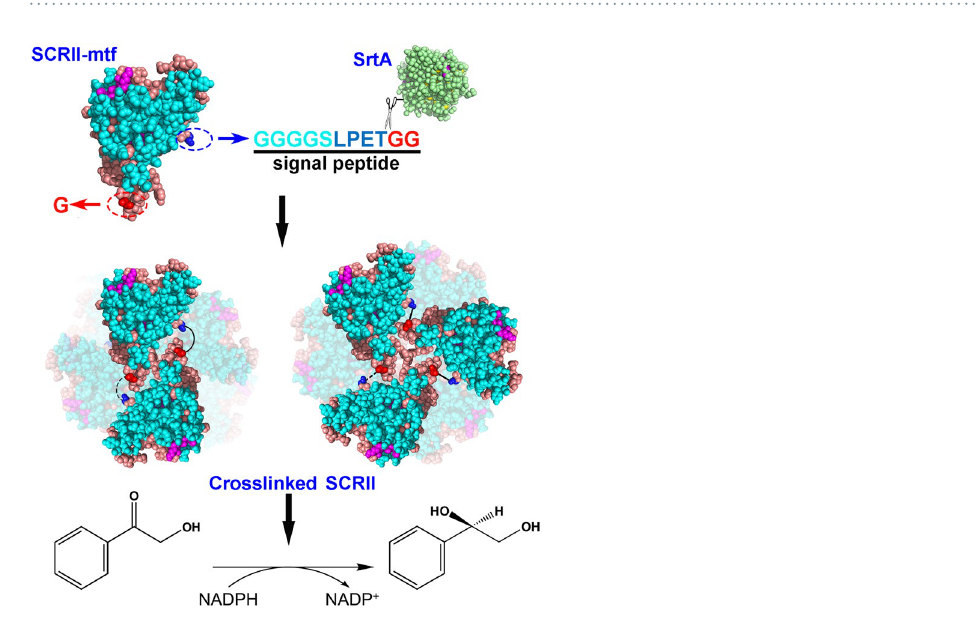
Figure 1. Schematic illustration showing the SrtA-mediated crosslinking of SCRII. GGGGSLPETGG tag was fused into the C-terminal end of SCRII. SrtA recognized and cleaved the tag, followed by the attack from the glycine at the N-terminal end to form crosslinked protein complexes (mainly dimers and trimers). The covalently bond dimers and trimers were used as units to form further oligomerisation, of which the intermolecular conformation was assumed in this work. The dotted line meaned possible covalent bond to form cyclic crosslinked SCRII. The crosslinked SCRII was subsequently applied to the asymmetric reduction of 2-HAP to ( S